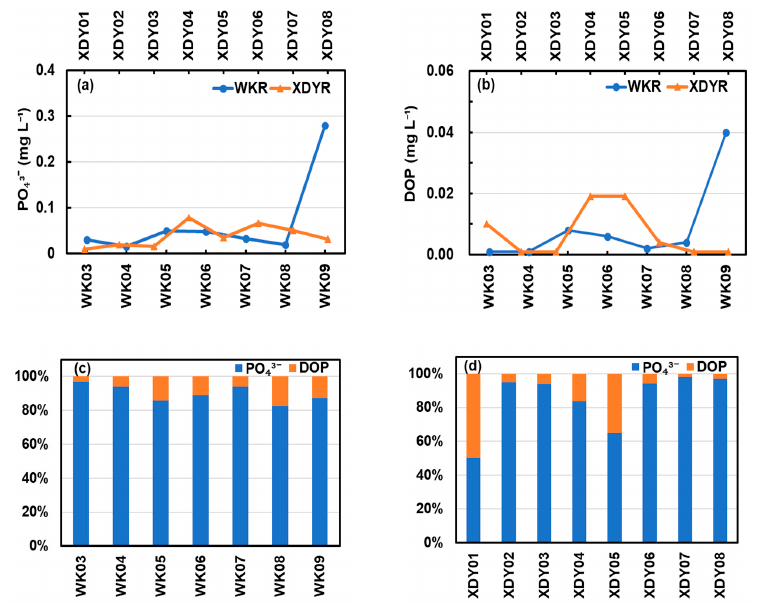
Figure 6. Spatial distribution of: ( a ) dissolved orthophosphate (PO 43 − ) and ( b ) dissolved organic phosphorus (DOP in the WangKuai reservoir route (WKR) and XiDaYang reservoir route (XDYR), and the percentages of PO 43 − and DOP in ( c ) the WKR and ( d ) the XDYR.